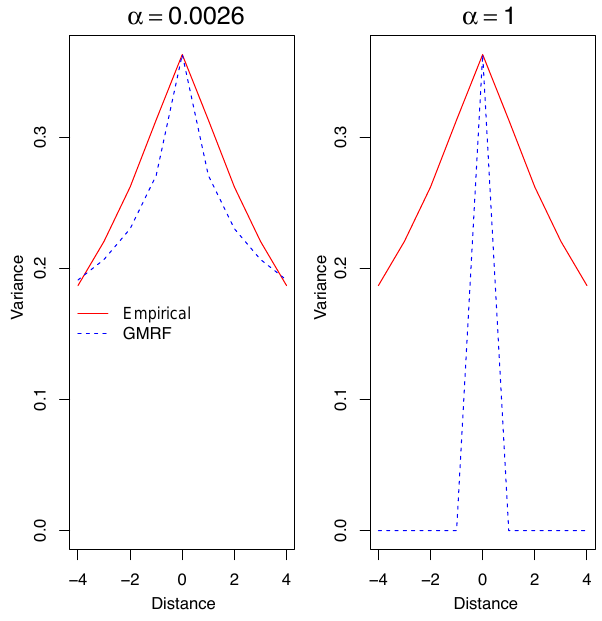
Figure 4. “Witch hat” graphs for air temperature on a 128 × 22 lat- tice of the tropics from 30 ◦ S to 30 ◦ N. The empirical estimates are given by the solid red line. The GMRF estimate is given by the dashed blue line. Table 1. Correlation matrix between four fields from CAM